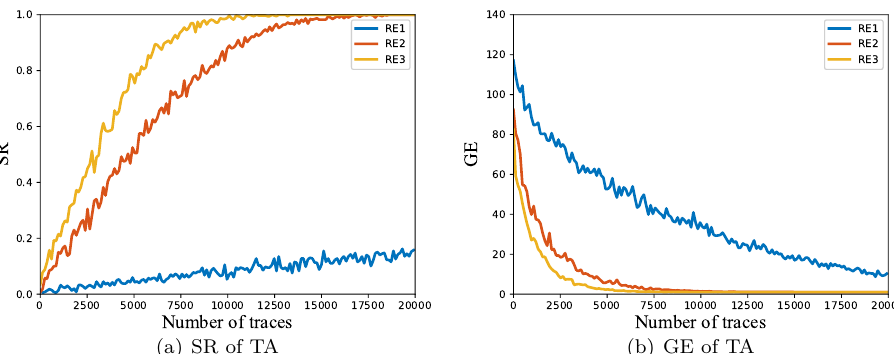
Figure 8: SR and GE results targeting the output of L Gadget for redundant